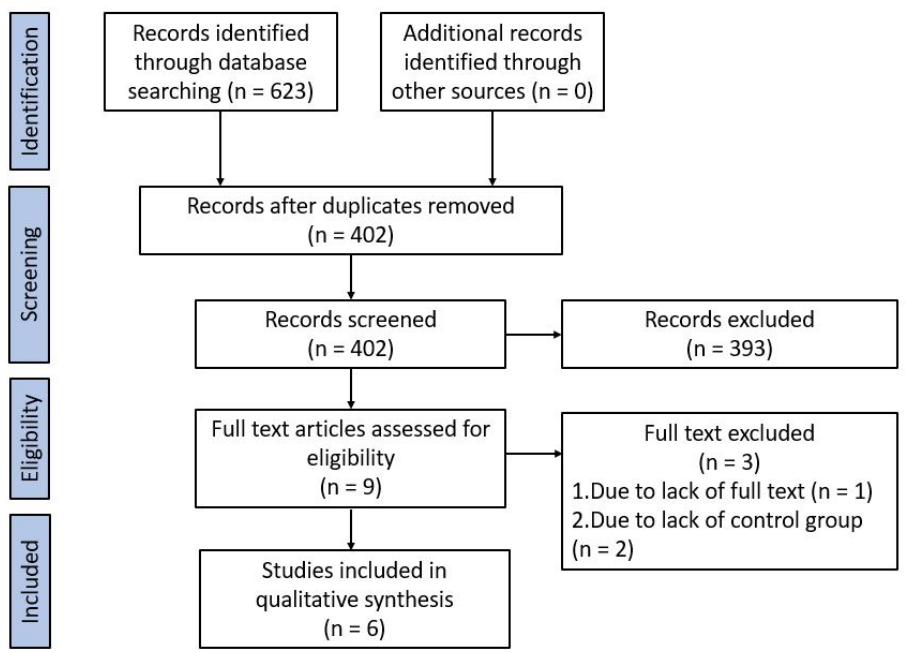
Figure 1. PRISMA flow chart of screening and selection results.